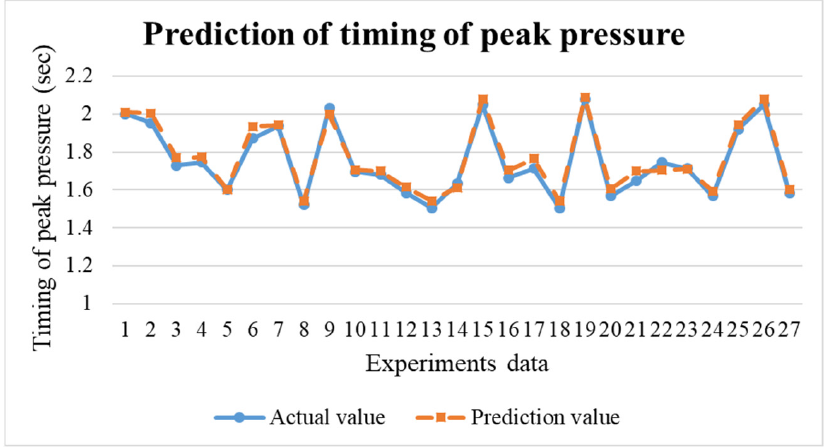
Figure 18. Prediction results of peak pressure.